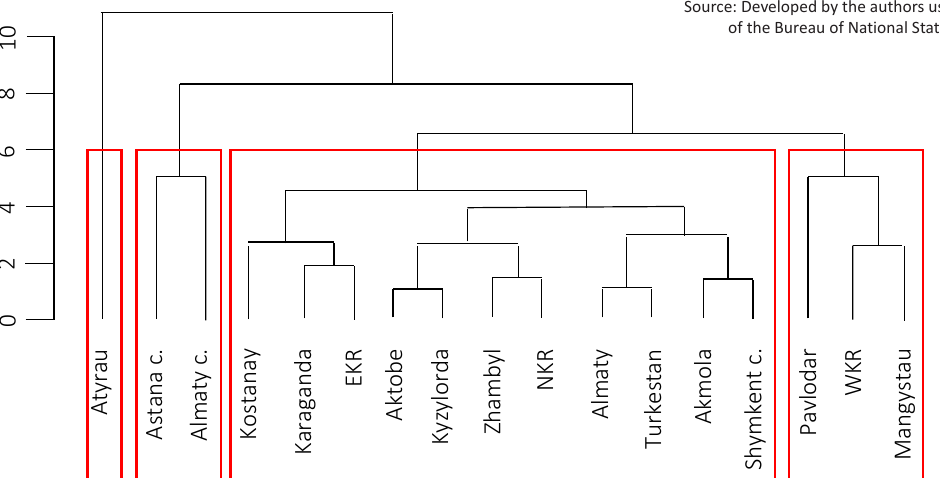
Figure 2. Dendrogram of clusters of regions of Kazakhstan, complete linkage